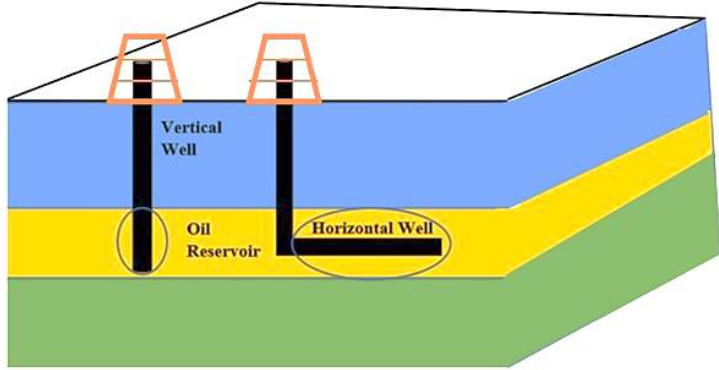
Figure 30. Horizontal well reaching wider section of formation.